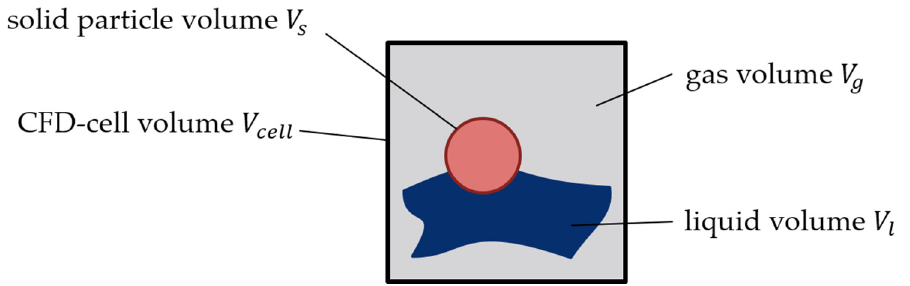
Figure 1. Schematic two-dimensional (2D) representation of the volume fractions at the coexistence of three phases in one CFD cell.